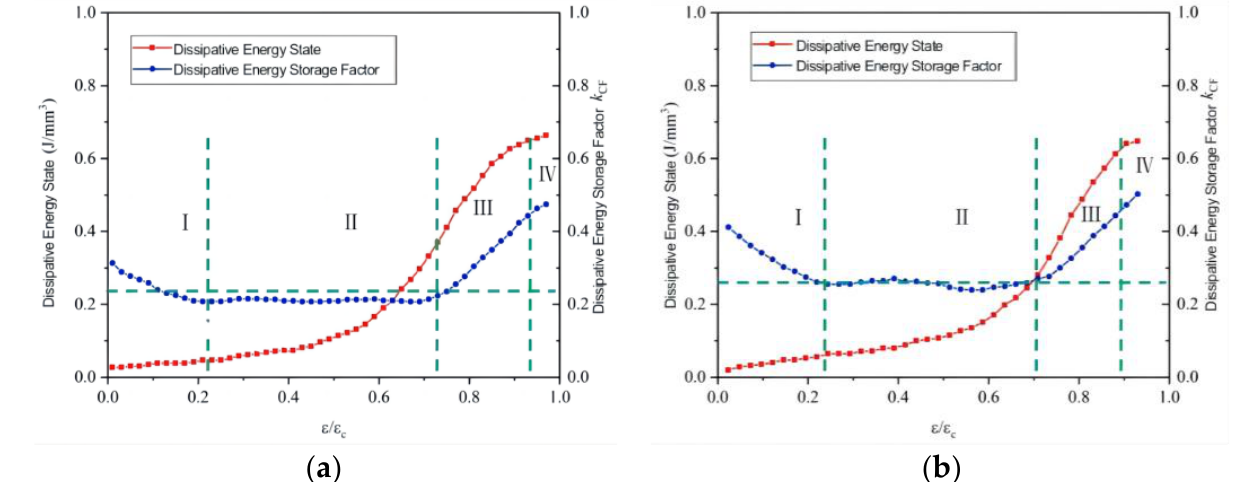
Figure 13. The evolution of energy storage factor during the failure process. The green line is used to delineate the different stages through which the coal samples in the diagram have gone ( a ) Dissipative energy stage and k CF of the coal sample S1. ( b ) Dissipative energy stage and k CF of the coal sample S2.